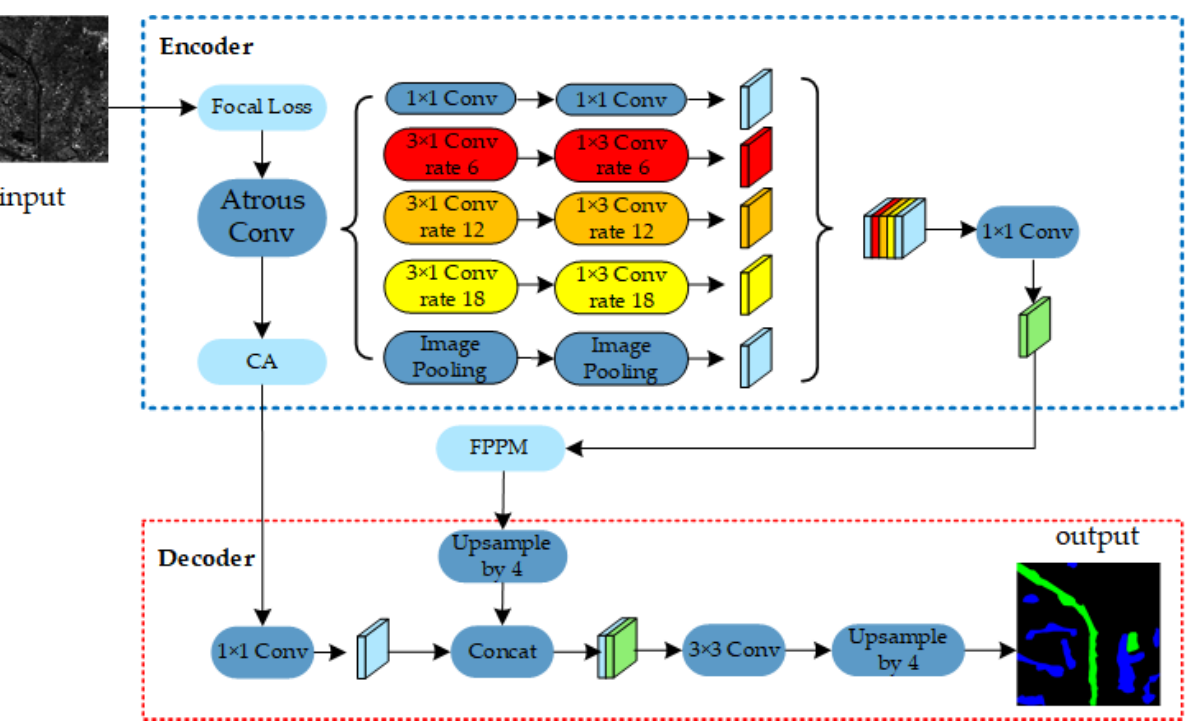
Figure 1. Schematic diagram of the improved Deeplabv3+ model.